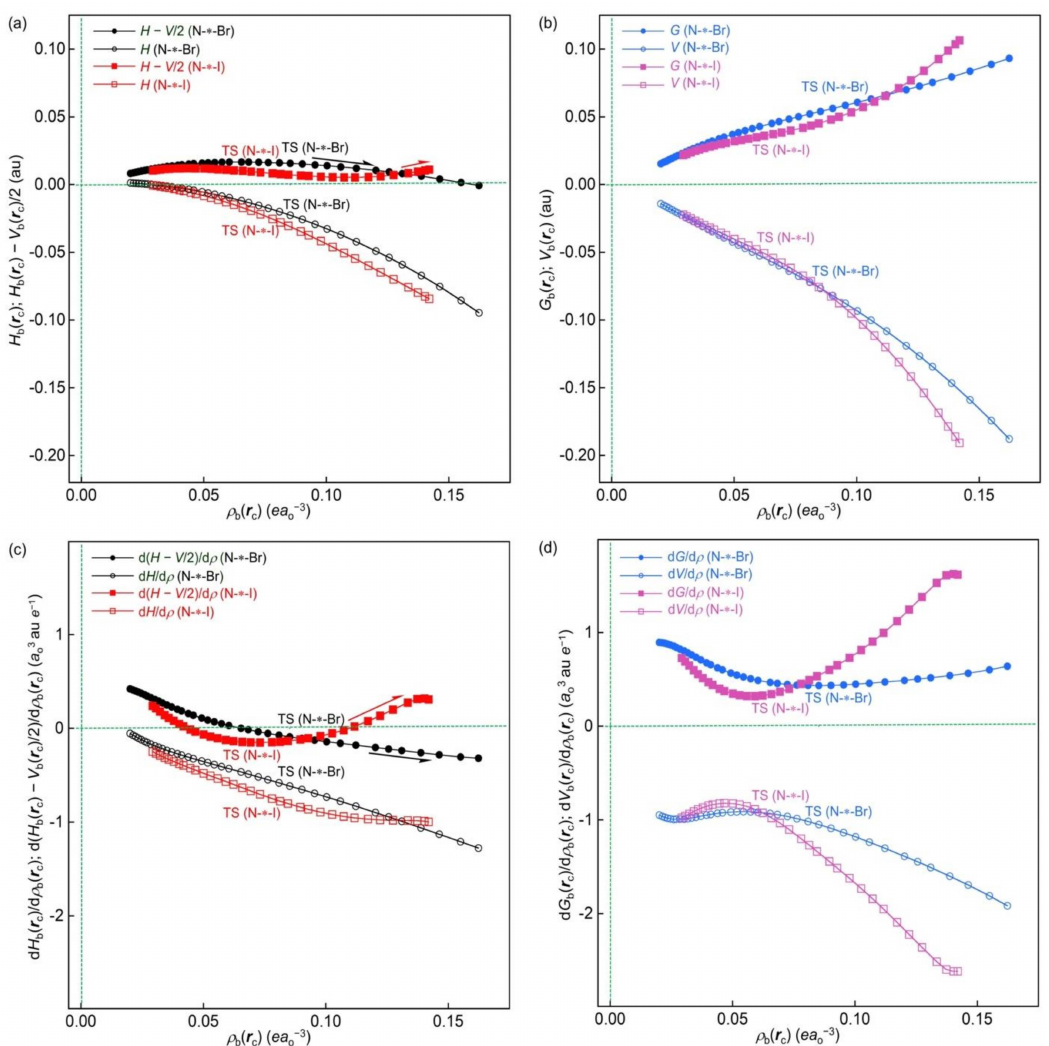
Figure 13. Plots of H b ( r c ) − V b ( r c )/2 and H b ( r c ) versus ρ b ( r c ) ( a ) G b ( r c ) and V b ( r c ) versus ρ b ( r c ) ( b ) for the wide range of the interaction distances around TS [MeI- ∗ -N- ∗ -BrMe(SO 2 CF 3 )], calcu- lated with MP2/BSS-C’. The perturbed structures are generated with IRC. Plots of d( H b ( r c ) − V b ( r c )/2)/d ρ b ( r c ) and d H b ( r c )/d ρ b ( r c ) versus ρ b ( r c ) ( c ) and dG b ( r c )/d ρ b ( r c ) and d V b ( r c )/d ρ b ( r c ) versus ρ b ( r c ) ( d ) around the TS, corresponding to ( a ) and ( b ), respectively.